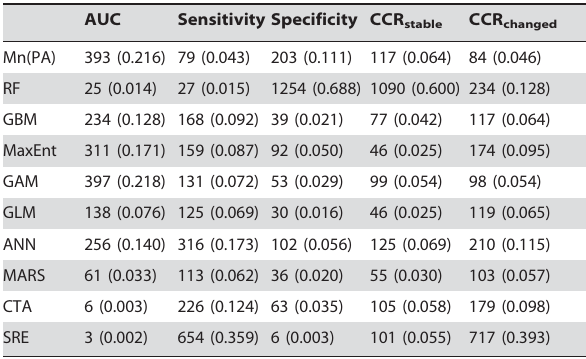
Number (and proportion) of best-predicted species